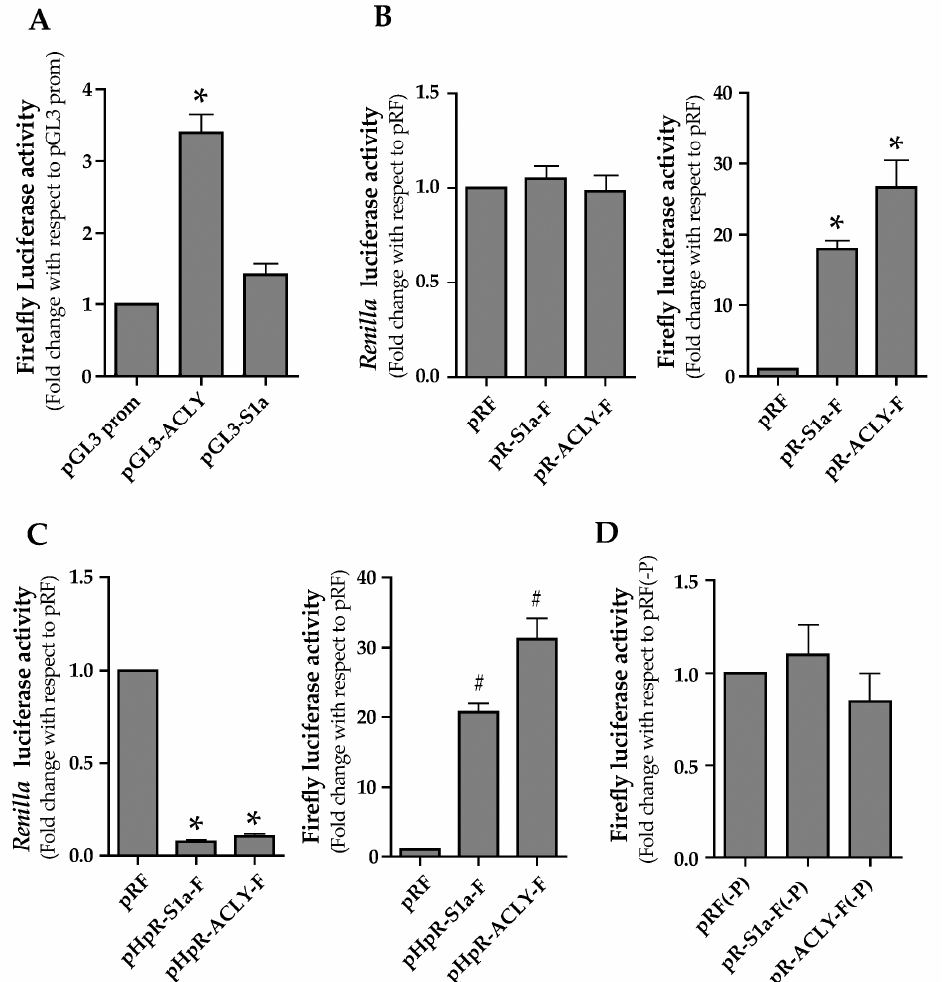
Figure 3. Evaluation of a putative internal ribosome entry site (IRES) in the 5 ′ UTR of ACLY mRNA. ( A ) HepG2 cells were co-transfected with pGL3prom, pGL3-ACLY or pGL3S1a constructs together with the control plasmid pcDNA3.1/HisB/lacZ. At 24 h after transfection, FL activity was measured and normalized with respect to β -galactosidase activity. Values are means ± S.D. ( n = 6) and are reported as a percentage of FL activity determined in cells transfected with the empty vector pGL3 prom. (pGL3 prom vs. pGL3-ACLY * p ≤ 0.05). ( B ) HepG2 cells were co-transfected with pR-S1a-F or pR-ACLY-F constructs, together with pcDNA3.1/HisB/lacZ used for the normalization of transfection efficiency. RL and FL activities, normalized to β -galactosidase activity, are reported as the fold change relative to those determined in cells transfected with the control vector pRF. Values are means ± S.D., ( n = 6). (pRF vs. pR-S1a-F and pR-ACLY-F * p ≤ 0.01). ( C ) HepG2 cells were co-transfected with pRF, pHpR-S1a-F or pHpR-ACLY-F, together with pcDNA3.1/HisB/lacZ used for the normalization of transfection efficiency. RL and FL activities, normalized to the β -galactosidase activity, were reported as the fold change relative to those determined in cells transfected with the control vector pRF. Values are means ± S.D., ( n = 6). (Right panel, pRF vs. pHpR-S1a-F and pHpR-ACLY-F * p ≤ 0.05; left panel, pRF vs. pHpR-S1a-F and pHpR-ACLY-F # p ≤ 0.01). ( D ) The promoterless pRF(-P) or pR-ACLY-F(-P) constructs were co-transfected together with pcDNA3.1/HisB/lacZ into HepG2 cells. At 24 h after transfection, cells were harvested for determination of FL activity, which was normalized to the β -galactosidase activity. Values were reported as the fold change relative to the FL activity measured in HepG2 cells transfected with pRF(-P). Values are means ± S.D., ( n = 6).